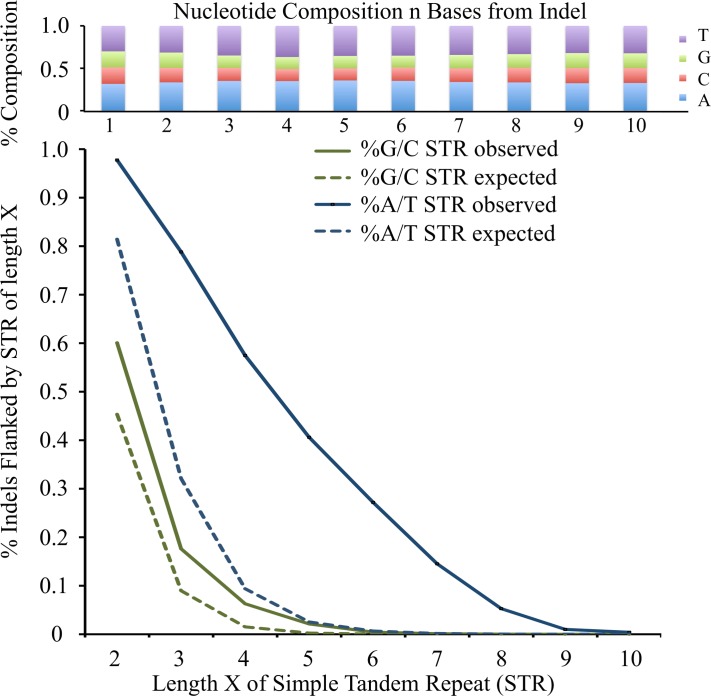
Top panel: base composition of ±10bp flanking singleton indel positions.X-axis–the ±1-10th base from indel position, 5’->3’ oriented. Y-axis–composition of A,C,G,T bases at that position across all indel flanking regions. Bottom panel: % of indels flanked by single base simple tandem repeats (STRs). X-axis–the length of monomer STR. Y-axis–the % of indels flanked by a monomer STR at least that long.